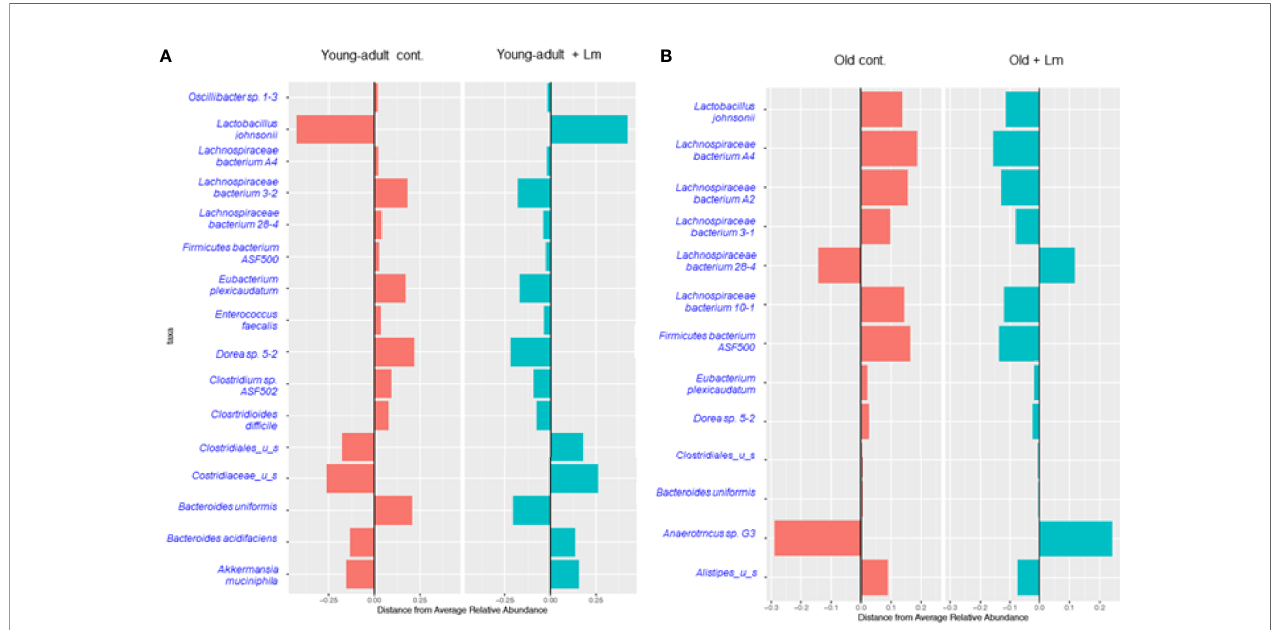
FIGURE 4 | Centroid classi fi cation based on relative abundance of fecal microbiota at the genus and species level in young-adult and old mice after Listeria monocytogenes (Lm) infection. (A) Top sixteen bacterial species that showed either an increase or decrease abundance in young-adult mice before and after L. monocytogenes infection. (B) Top thirteen frequently bacterial species that showed either an increase or decrease abundance in old mice before and after L. monocytogenes